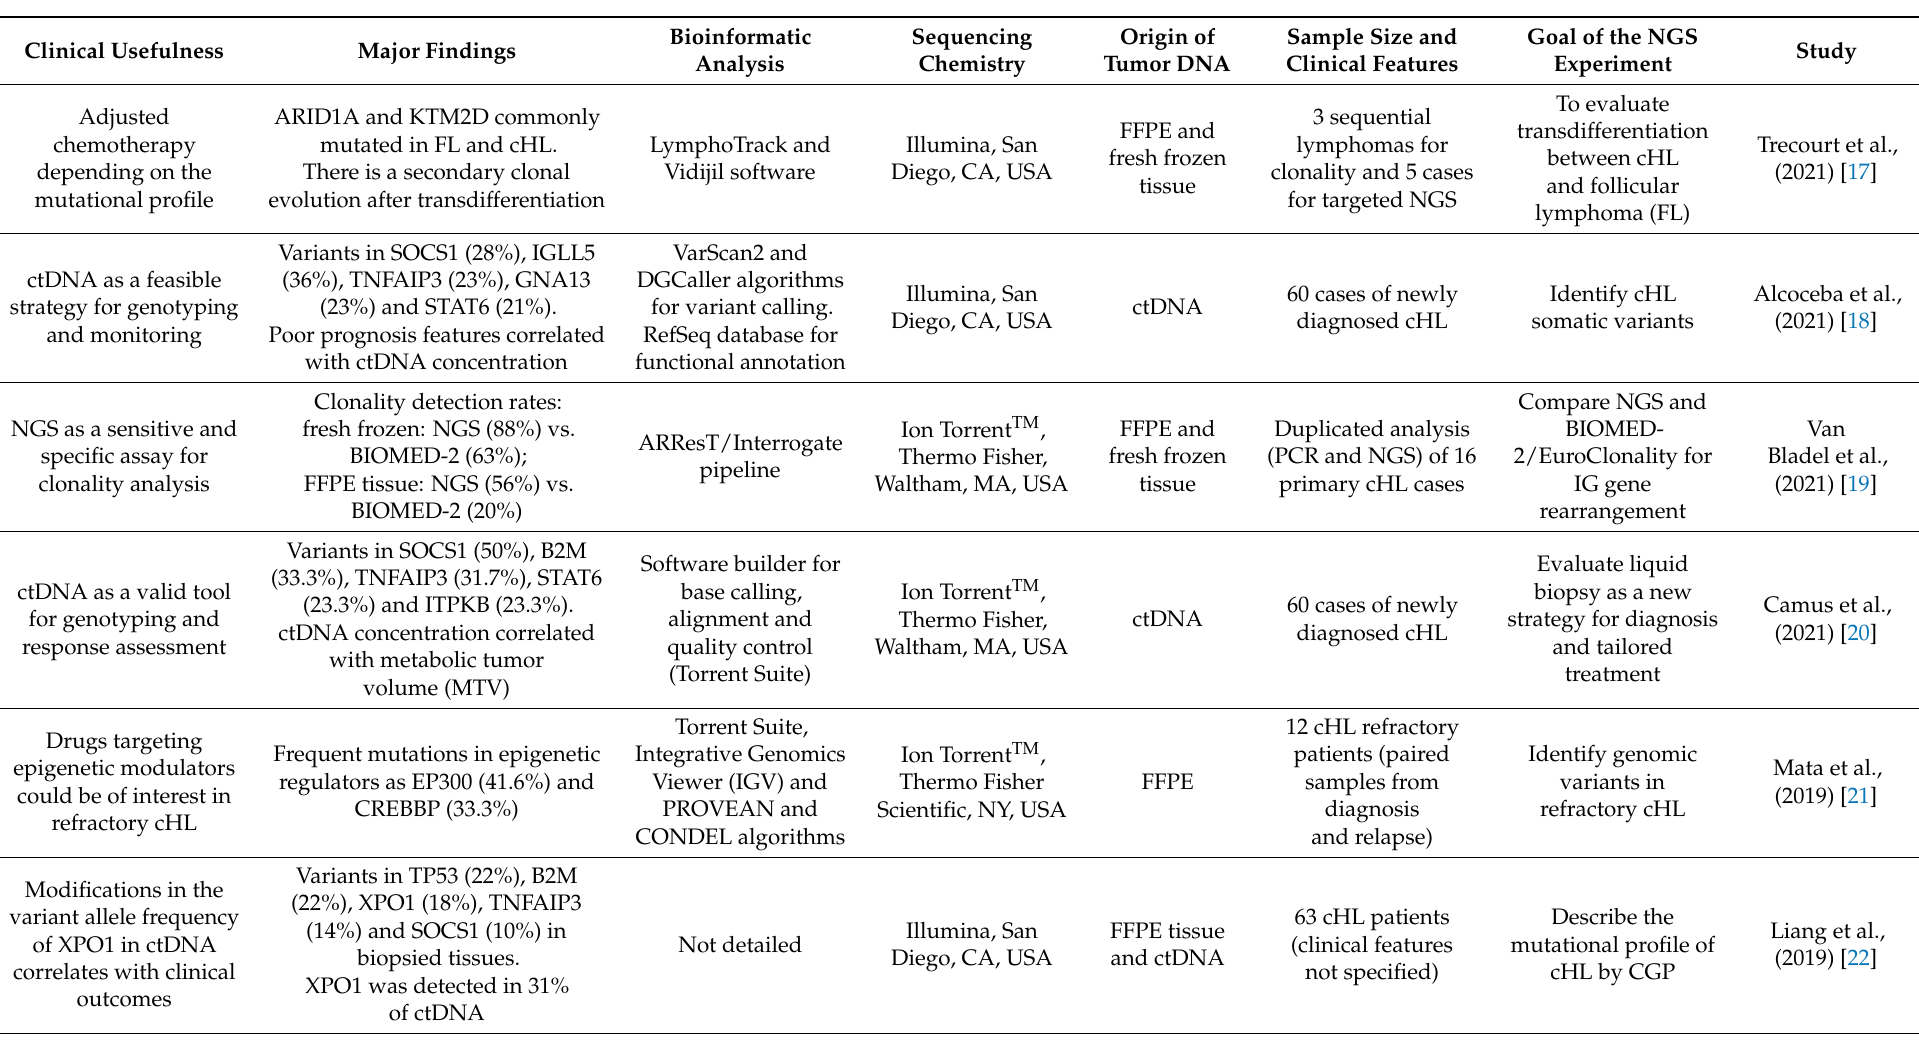
Table 2. Main characteristics of the studies included in the present systematic